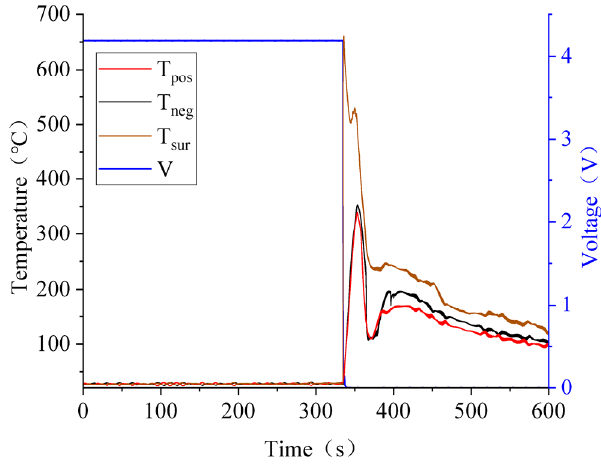
Figure 19. One hundred percent SOC state battery curve.